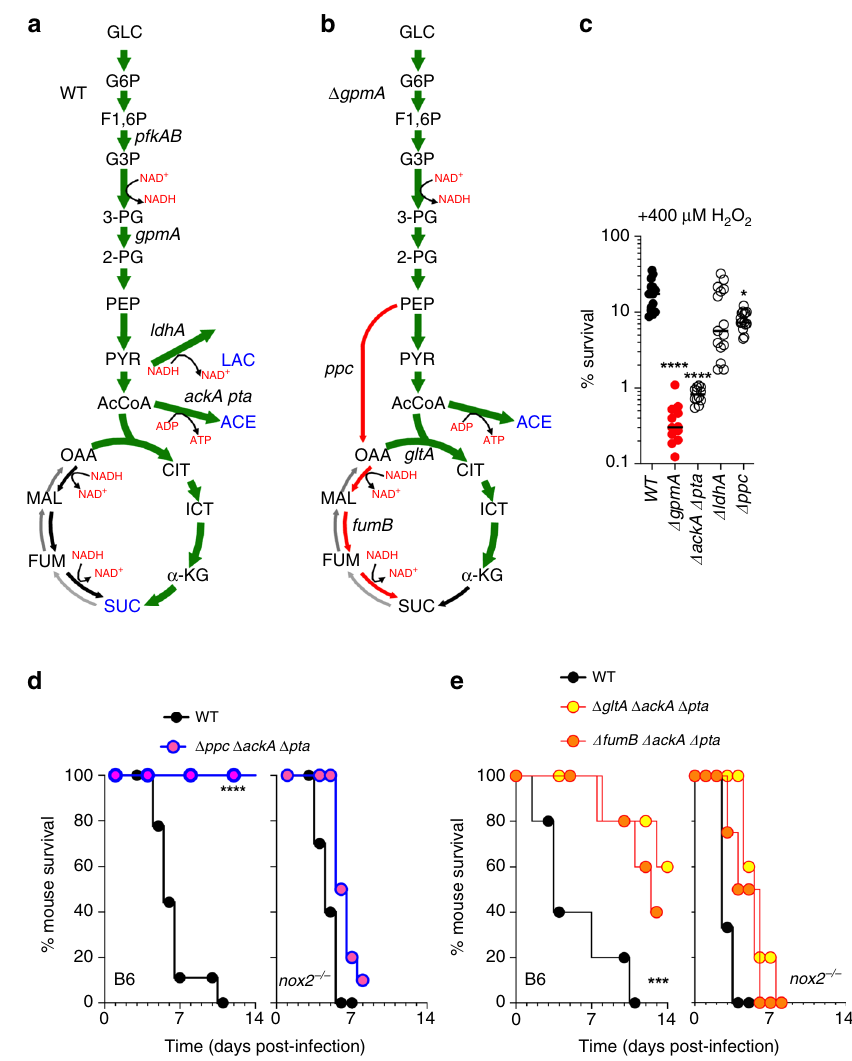
Fig. 2 Oxidative stress induces adaptive glycolytic switch. Schematic representation of central metabolites in a wild-type and b Δ gpmA Salmonella after growth for 30 min with 2.5 mM H 2 O 2 in aerobic MOPS-glucose media. Green arrows denote pathways upregulated in response to H 2 O 2 . In blue is shown increased production of mixed fermentation products lactate (LAC), acetate (ACE) and succinate (SUC). Red arrows denote defective anaplerotic utilization of phosphoenolpyruvate (PEP), which accumulates in Δ gpmA Salmonella , for the formation of reductive TCA intermediates, which are present in lower concentrations in Δ gpmA Salmonella (see Supplementary Fig. 3 and Supplementary Data 3 and 4). Glucose (GLC), glucose 6-P (G6P), glyceraldehyde 3P (G3P), 3-phosphoglycerate (3-PG), 2-phosphoglycerate (2-PG), pyruvate (PYR), acetyl-CoA (AcCoA), citratre (CIT), isocitrate (ICT), α -ketoglutarate ( α -KT), succinate (SUC), fumarate (FUM), malate (MAL), oxaloacetate (OAA). Phosphofructokinase ( pfkAB ), phosphoglycerate mutase ( gpmA ), lactate dehydrogenase ( ldhA ), PEP carboxylase ( ppc ), citrate synthase ( gtlA ), fumarase B ( fumB ), acetate kinase ( ackA ), phosphotranacetylase ( pta ). N = 5. c Killing of Salmonella 2 h after exposure to 400 μ M H 2 O 2 in MOPS-glucose media. Median; N = 15 except for Δ gpmA and Δ ldhA where N = 12. The data were analyzed by one-way ANOVA. *, **** p < 0.05, 0.0001, respectively, df = 59, F = 19.34. d , e Survival of C57BL/6 and nox2 − / − mice after i.p. challenge with ~200 CFU of Salmonella . Data in d are N = 9 for C57BL/6 and 10 for nox2 − / − mice; Data in e are N = 5. *, **, ***, p < 0.05, 0.01 and 0.001, respectively, by Log-rank Mantel-Cox test (d, df = 1, e, df = 2)(see also Supplementary Figs. 5a, b). All measurements were taken from distinct samples. Source data are included in Source Data fi H 2 O 2 diminishes Δ pH in Salmonella . GAPDH oxidizes (Supplementary Fig. 6a) than wild-type controls, demonstrating glyceraldehyde-3P in glycolysis. In the process, NAD + accepts that Δ gpmA Salmonella are at least as capable of balancing the hydrogen from the aldehyde group of glyceraldehyde-3-P to redox and producing ATP as wild-type cells. Because Δ gpmA generate NADH. To ensure sustained GAPDH-dependent gly- Salmonella is defective in NADH-consuming fermentation colytic activity, NAD + must be regenerated. Facultative anae- reactions, we measured the capacity of this mutant to aero- robes replenish NAD + from NADH by fermenting glucose to bically respire, an activity that oxidizes NADH. Polarographic lactate, ethanol, and succinate. Given the defective production studies showed that Δ gpmA Salmonella consumes more O 2 than of succinate and lactate by Δ gpmA Salmonella , we compared wild-type controls, but showed similar rates as wild-type con- NADH/NAD + ratios in wild-type and Δ gpmA Salmonella . We trols when complemented with a gpmA allele expressed from the low copy pWSK29 plasmid (Fig. 3b). Enhanced respiratory found that Δ gpmA Salmonella contained lower NADH/NAD + activity provides a reasonable explanation for the ability of ratios (Fig. 3a) and slightly higher ATP concentrations